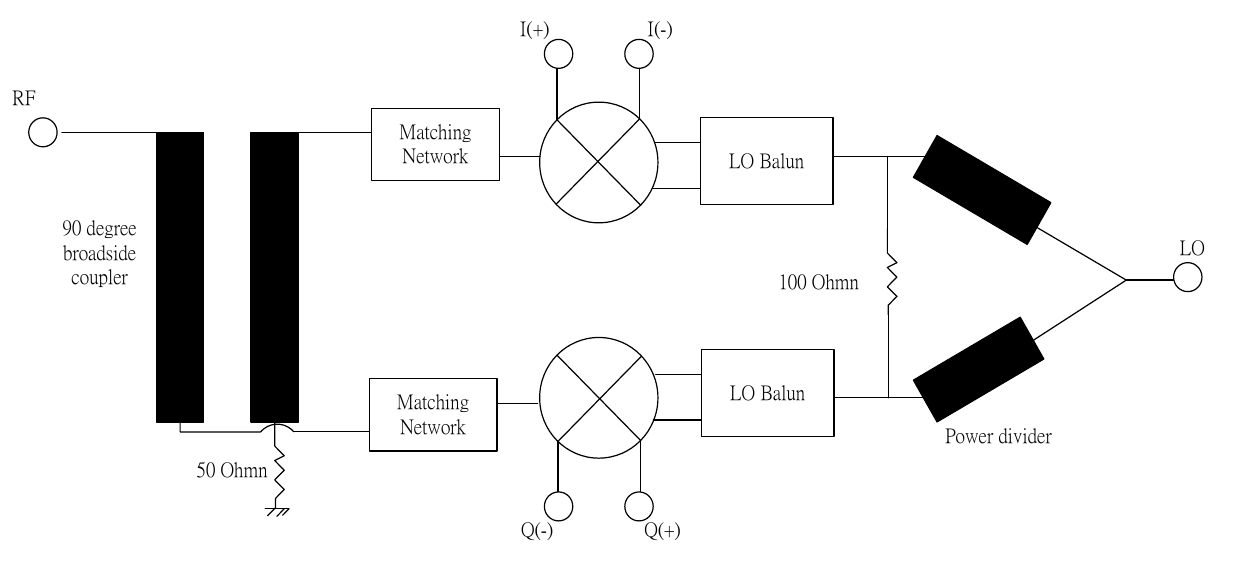
Figure 12. Block diagram of the MMW I/Q